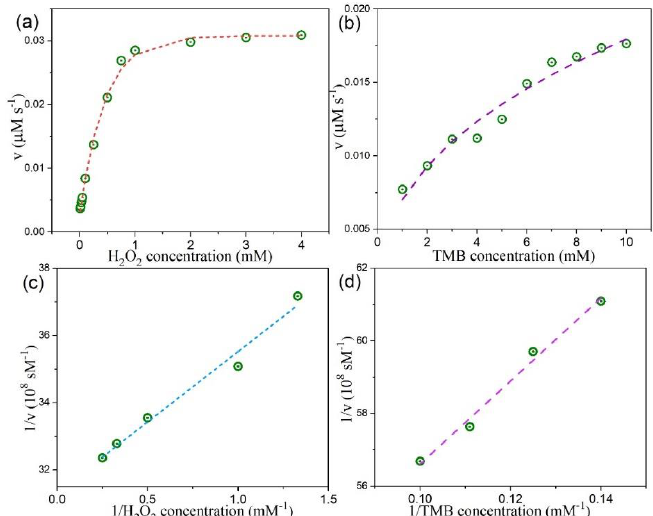
Figure 10. Steady-state kinetic assay of 2D CTAB-MoSe 2 nanosheets. ( a ) Varying the concentrations of H 2 O 2 while the concentration of TMB was 5 mM. ( b ) Varying the concentrations of TMB while the concentration of H 2 O 2 was 0.75 mM. The double-reciprocal plots for the concentration of ( c ) H 2 O 2 and ( d ) TMB.